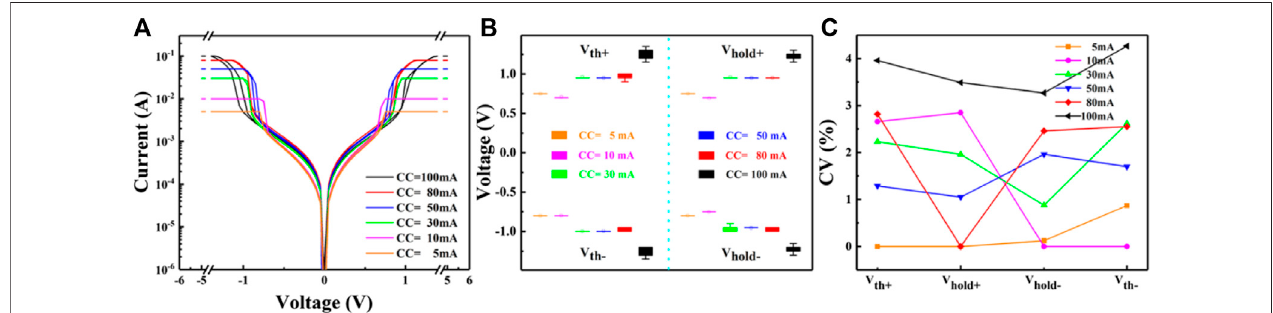
FIGURE 2 | (A) I-V curve of the Ti/NbO x /Ti/Pt device under different compliance current (CC). (B) Voltage distribution of the device under different CC. (C) The CV value of the device under different CC.